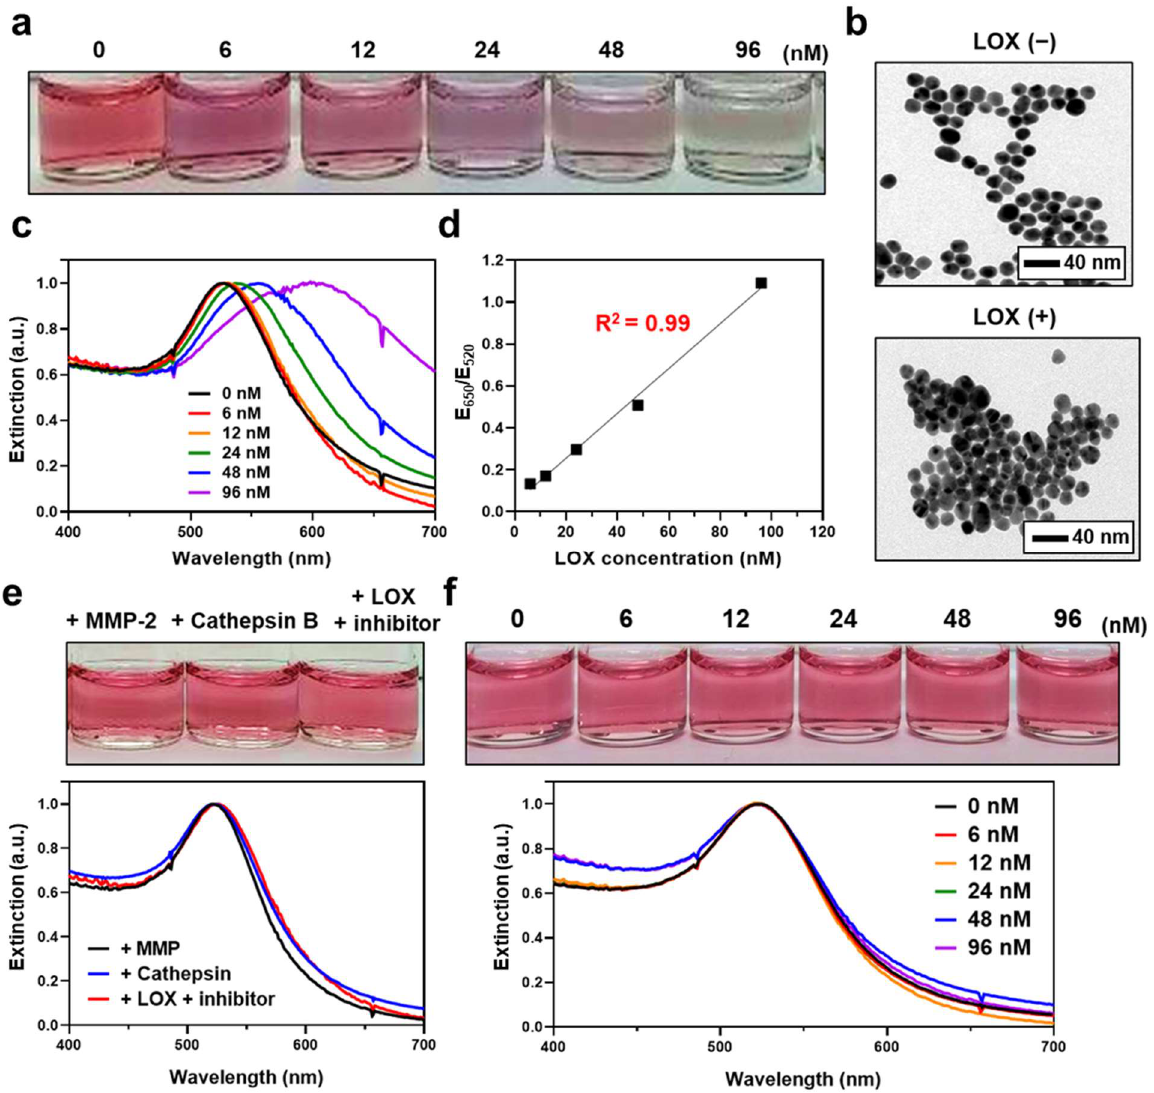
Figure 4. ( a ) Photographs showing the colors of LS-AuNP suspension after the addition of different concentrations of LOX. ( b ) TEM images of the LS-AuNPs before (upper panel) and after (lower panel) the addition of LOX (96 nM). ( c ) Changes in the UV/Vis extinction spectra of LS-AuNPs with different concentrations of LOX. ( d ) Calibration curve for LOX determination. Quantitative analysis was performed by measuring the extinction values at 650 nm normalized by extinction values at 520 nm (E 650 /E 520 ). ( e ) Photographs and corresponding UV/Vis extinction spectra of LS-AuNPs after the addition of MMP-2, cathepsin B, or LOX + LOX inhibitor (β-aminopropionitrile). ( f ) Photographs and corresponding UV/Vis absorption spectra of control AuNPs after the addition of different concentrations of LOX.